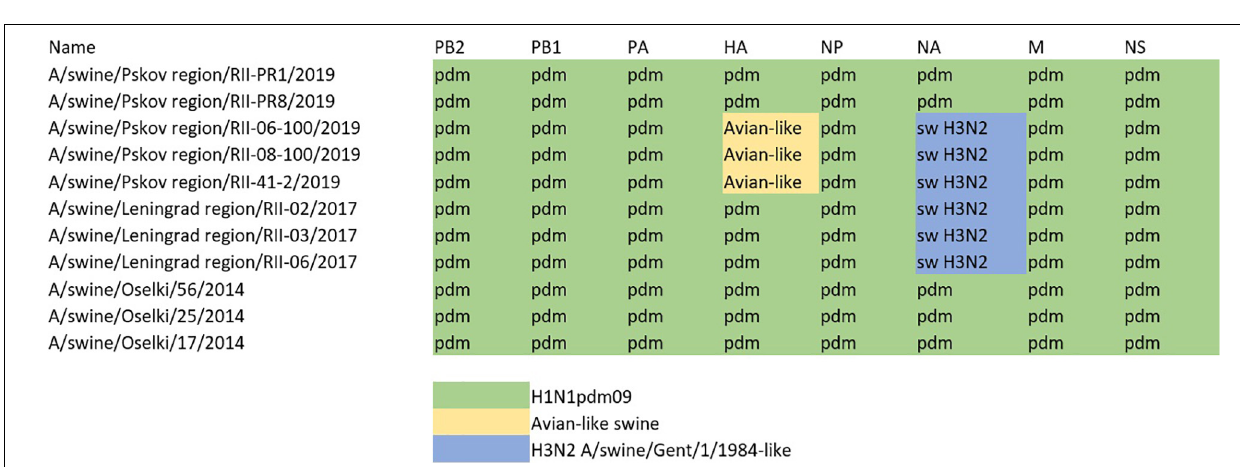
internal segments of swine influenza viruses described in the study. The genetic data was uploaded to the PubMed sequence read archive (SRA, Accession number